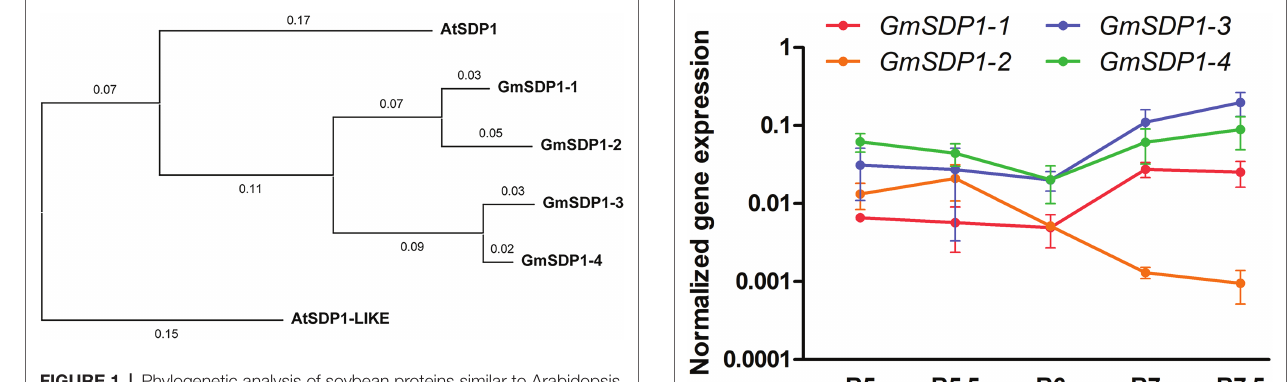
FIGURE 1 | Phylogenetic analysis of soybean proteins similar to Arabidopsis SDP1. The phylogenetic tree was constructed with MEGA X using the neighbor-joining method. Numbers on branches represent evolutionary distance in substitutions per amino acid. AtSDP1-LIKE (At3g57140) is the Arabidopsis paralog most similar to AtSDP1 (At5g04040) and was included for comparison. GmSDP1-1, Glyma.02 g190000; GmSDP1-2, Glyma.10 g105200; GmSDP1-3, Glyma.19 g132900; GmSDP1-4, Glyma.03 g130900.